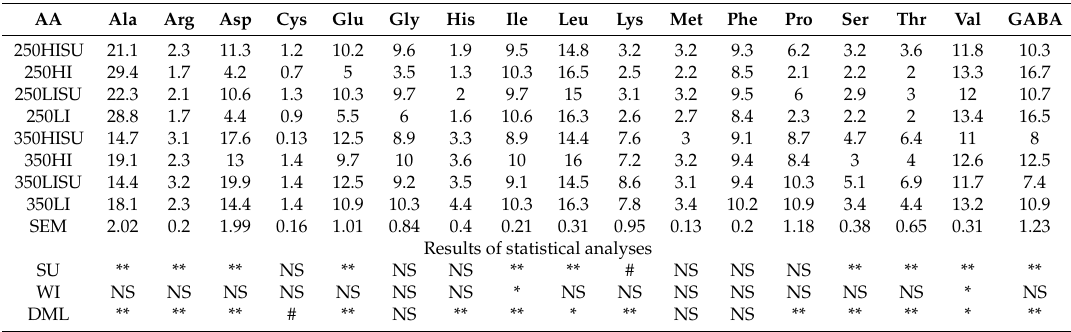
Table 3. Effect of sucrose addition (SU), wilting intensity (WI), and dry matter (DM) level (DML) on contents (g kg − 1 DM) of total amino acids (AA; the sum of peptide-bound and free AA) and gamma-aminobutyric acid (GABA) in lucerne silages.